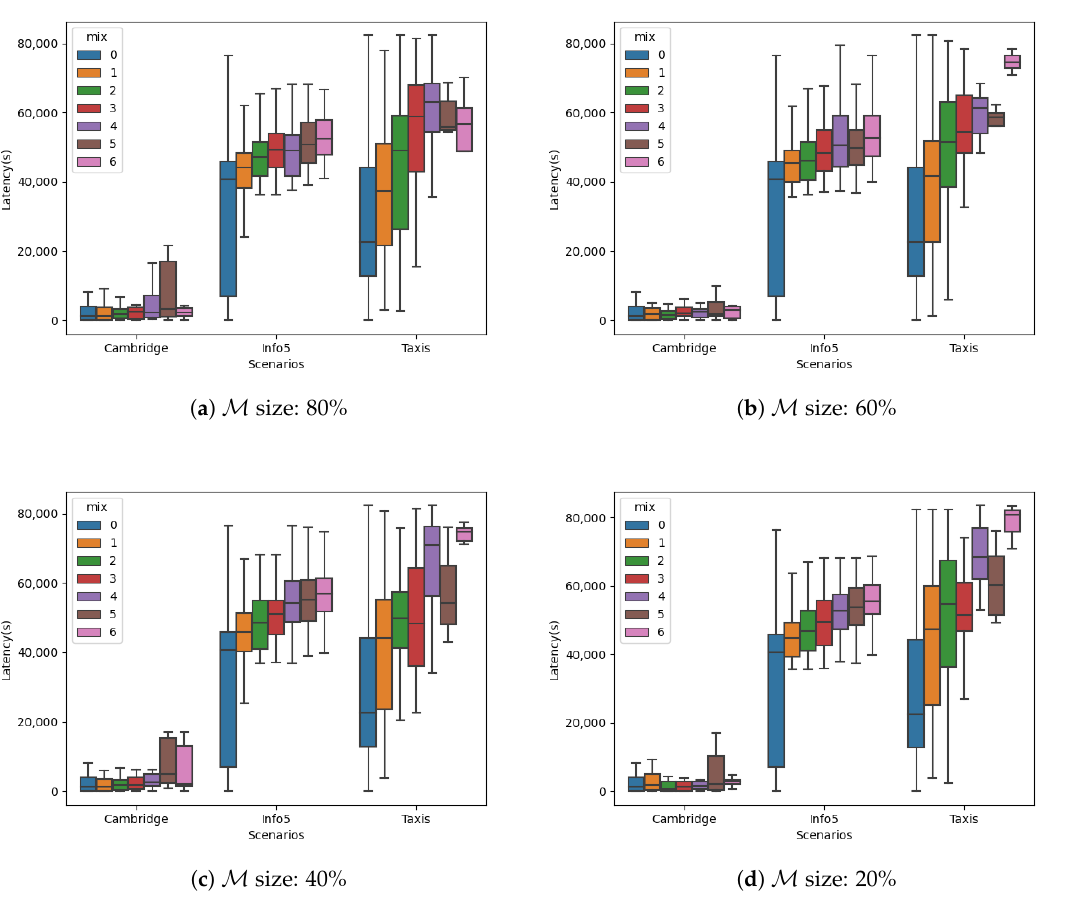
Figure 4. Latency with random mix